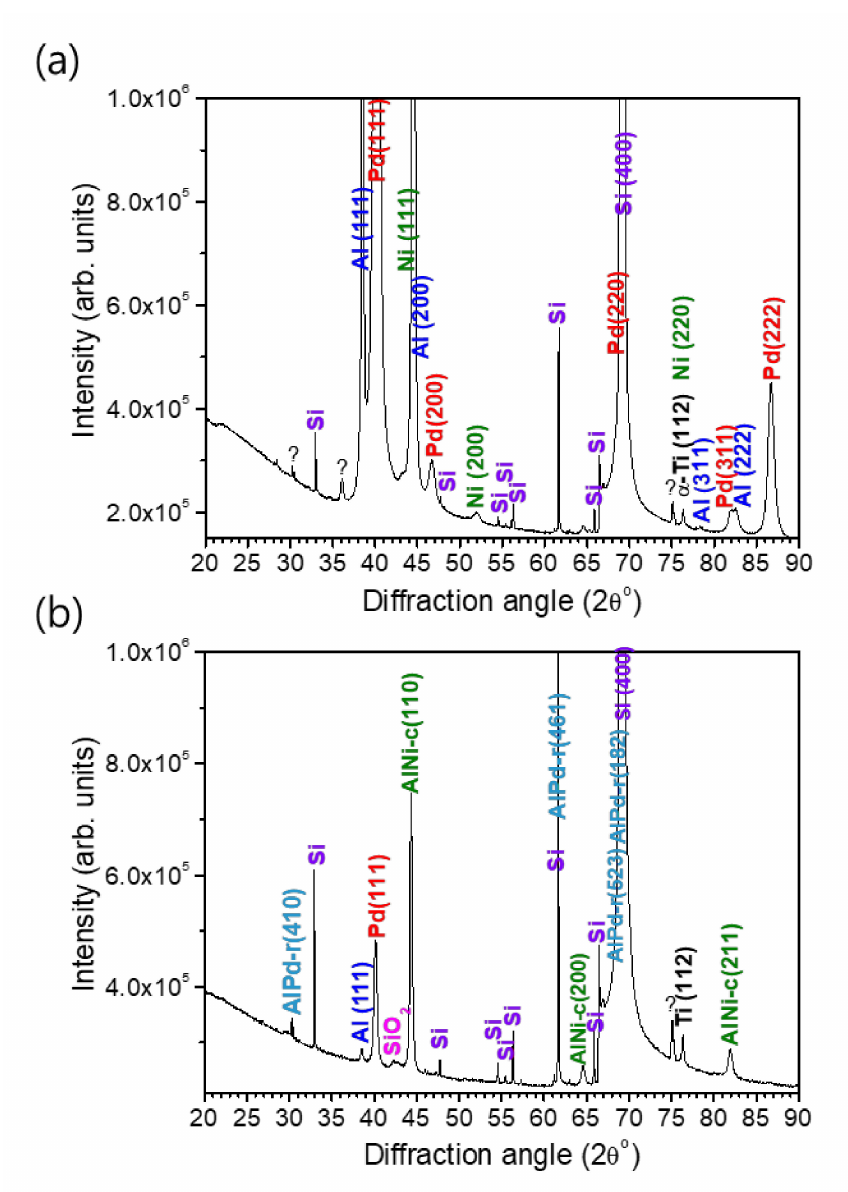
Figure 22. XRD patterns of Pd/Al-Ni/Al MS-iRMS on the SiO 2 /Si-substrate. ( a ) As-deposited sample; ( b ) Reaction product after electrical